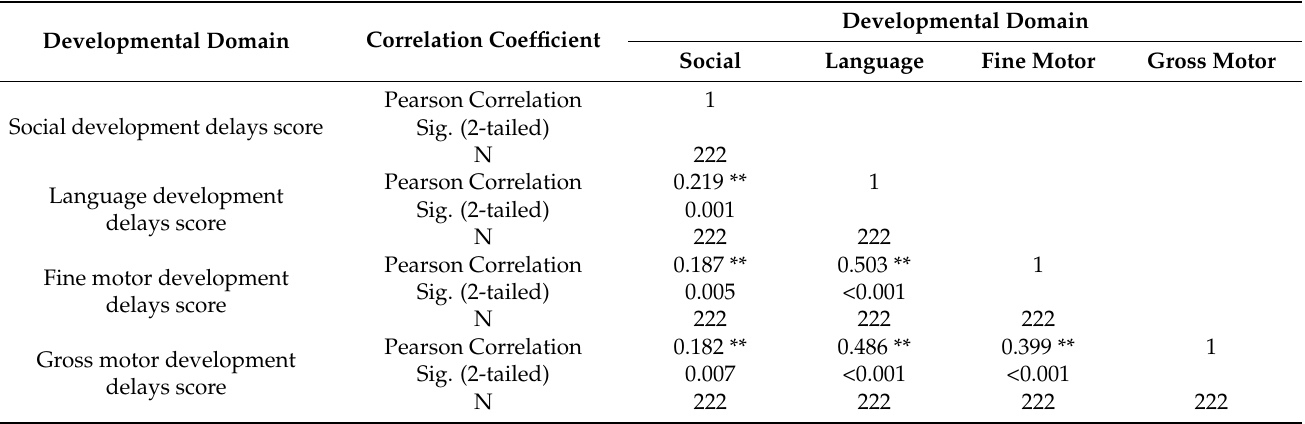
Table 3. Correlation between scores of different development